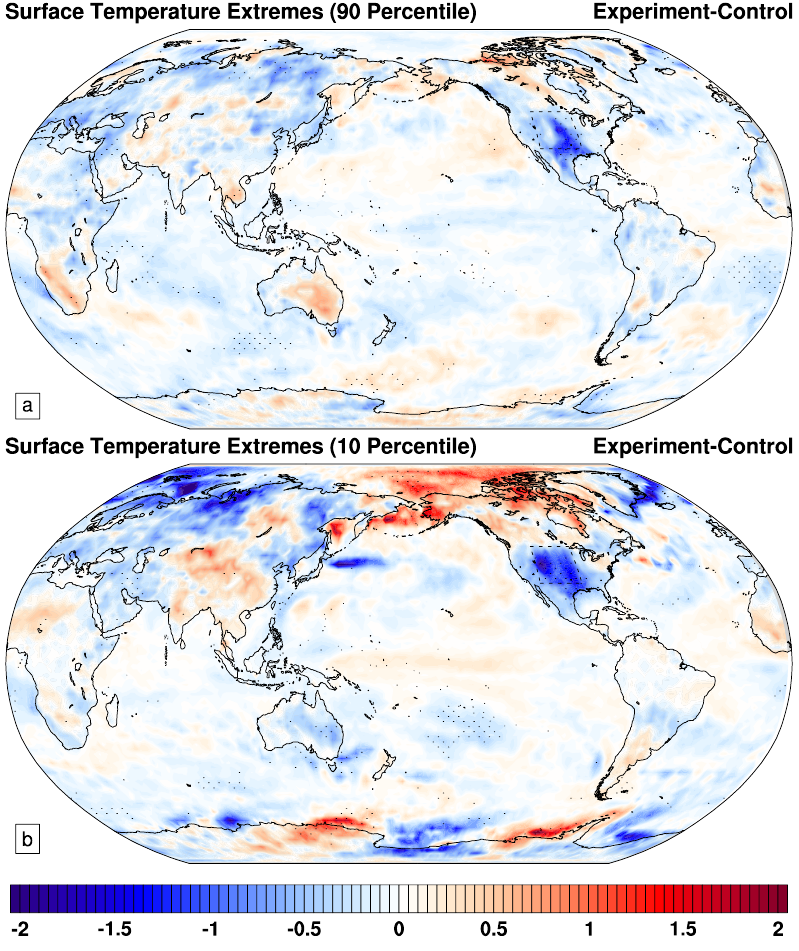
Figure 3. The sam as Figure 1 but for the change in: ( a ) top decile (90th percentile); and ( b ) the bottom decile (10th percentile) of the temporal distribution of surface temperature. A 90% significance level is shown as